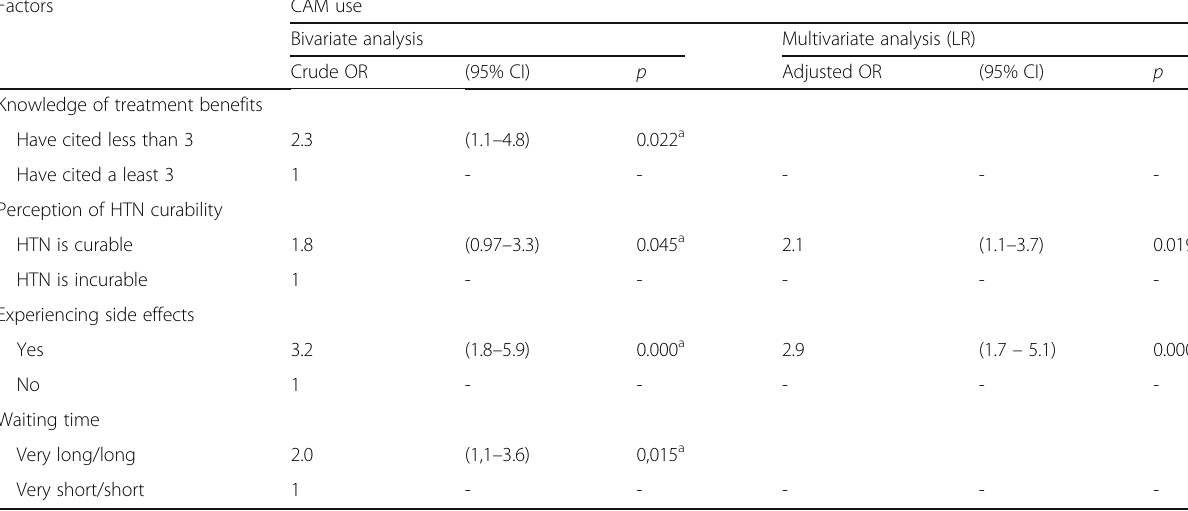
Table 8 Bivariate and multivariate analysis determinants of CAM use